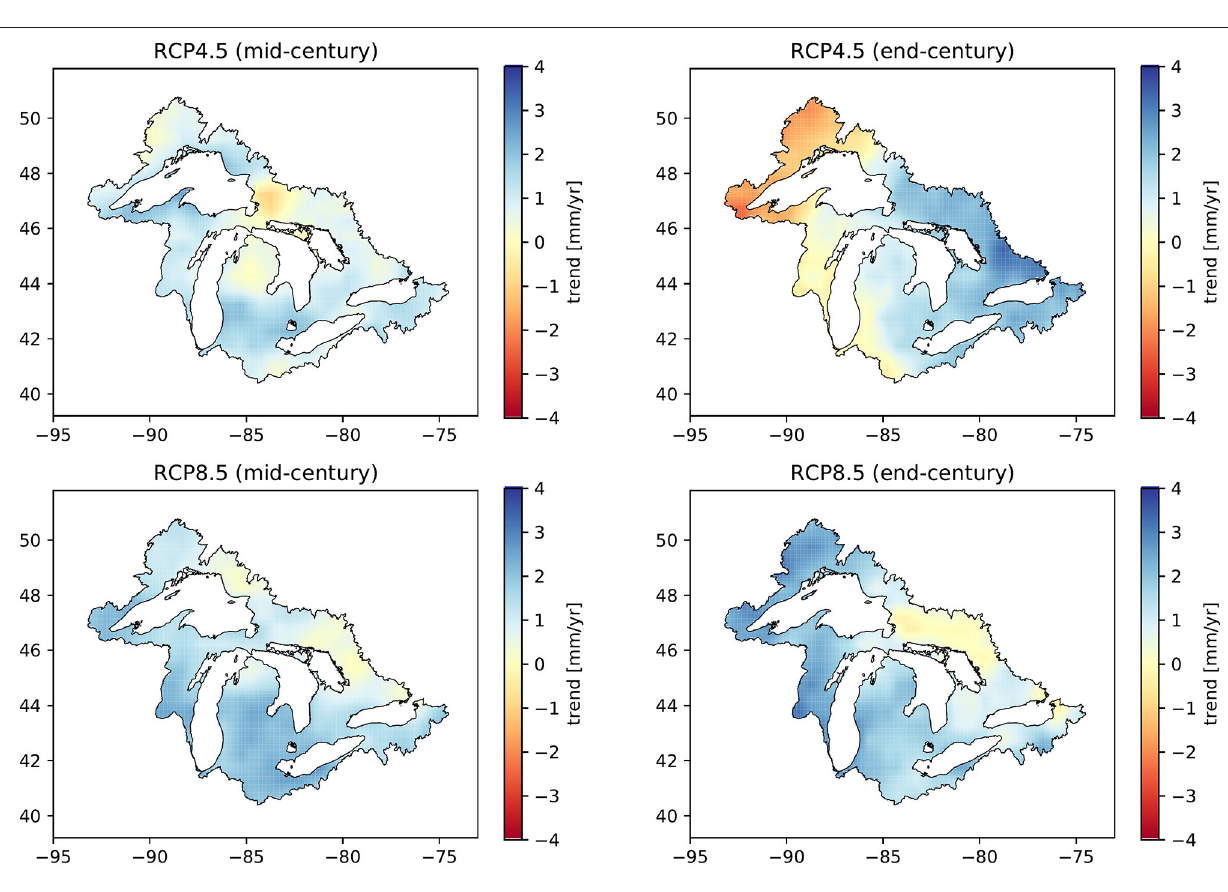
FIGURE 3 | Trend in annual over-land precipitation for RCP4.5 and RCP8.5 scenarios in mid- and end-century